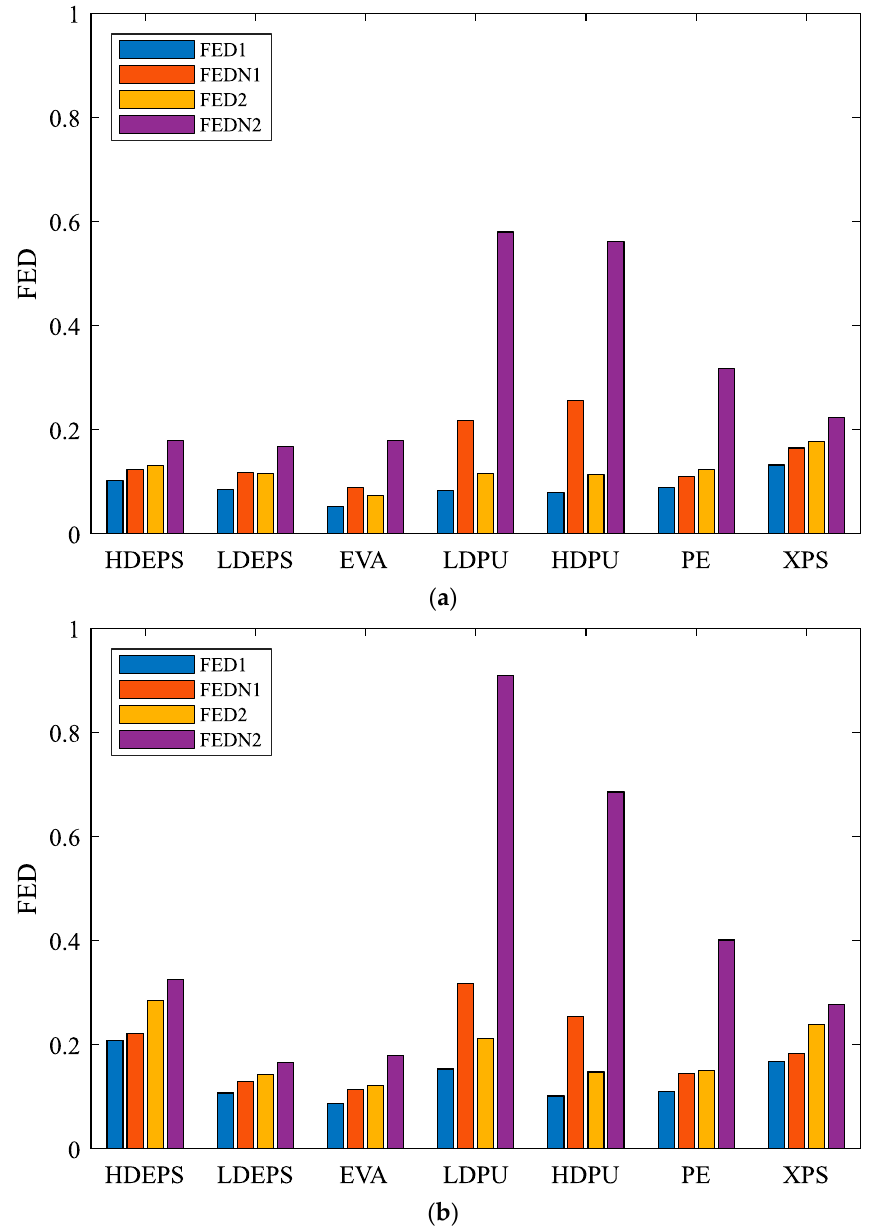
Figure 8. Fractional effective dose of polymers at ( a ) 35 kW/m 2 and ( b ) 50 kW/m 2 heat